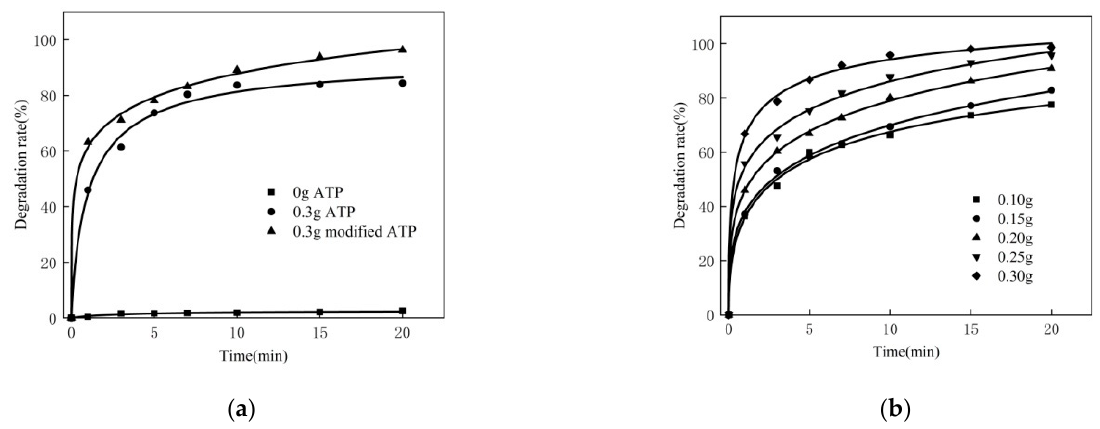
Figure 3. ( a ) Performance of modified ATP and ATP. ( b ) Effect of dosage of